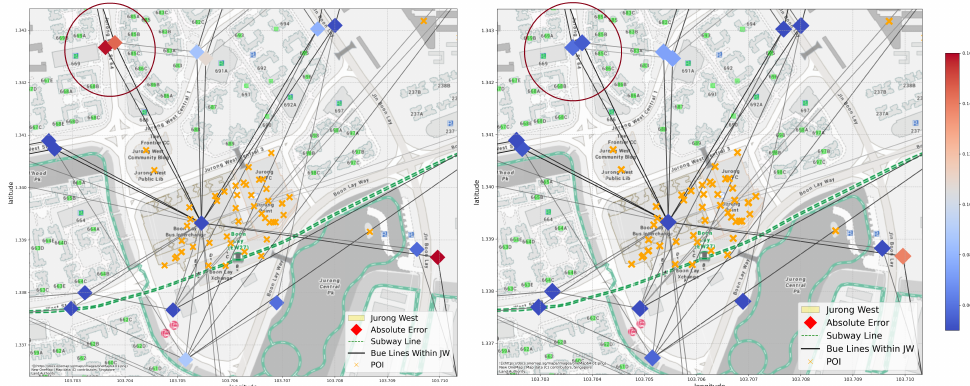
Figure 8. An example of a successful prediction in our GCN model. The two nodes in the circled area have more accurate attractiveness predictions from GCN ( right ) than from MLP ( left ). Both nodes locate in a residential area with no POIs nearby, but they are conveniently connected to other areas, especially the Jurong Point business hub, through bus lines. The poor MLP performance might be due to the lack of local POI information within the node area, but GCN can easily amend this issue by aggregating this information from the neighboring